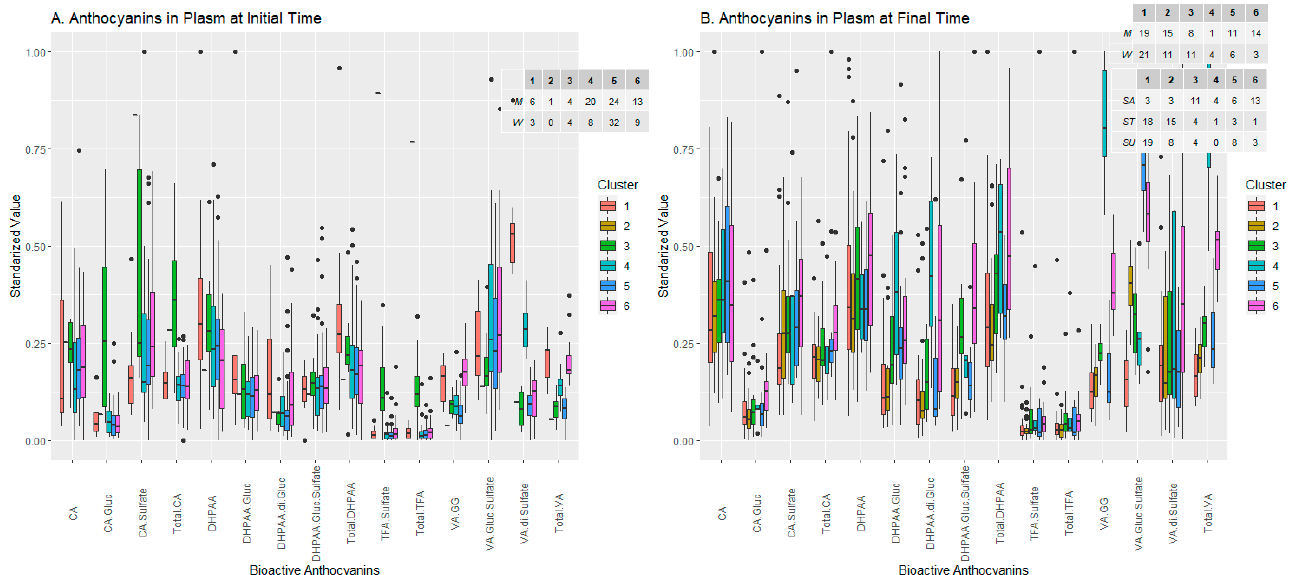
Figure 4. Levels of bioactive anthocyanin molecules within the groups generated by clustering analysis before ( A ) and after ( B ) beverage consumption, and composition of groups in terms of the sexes and sweeteners added to the drink.